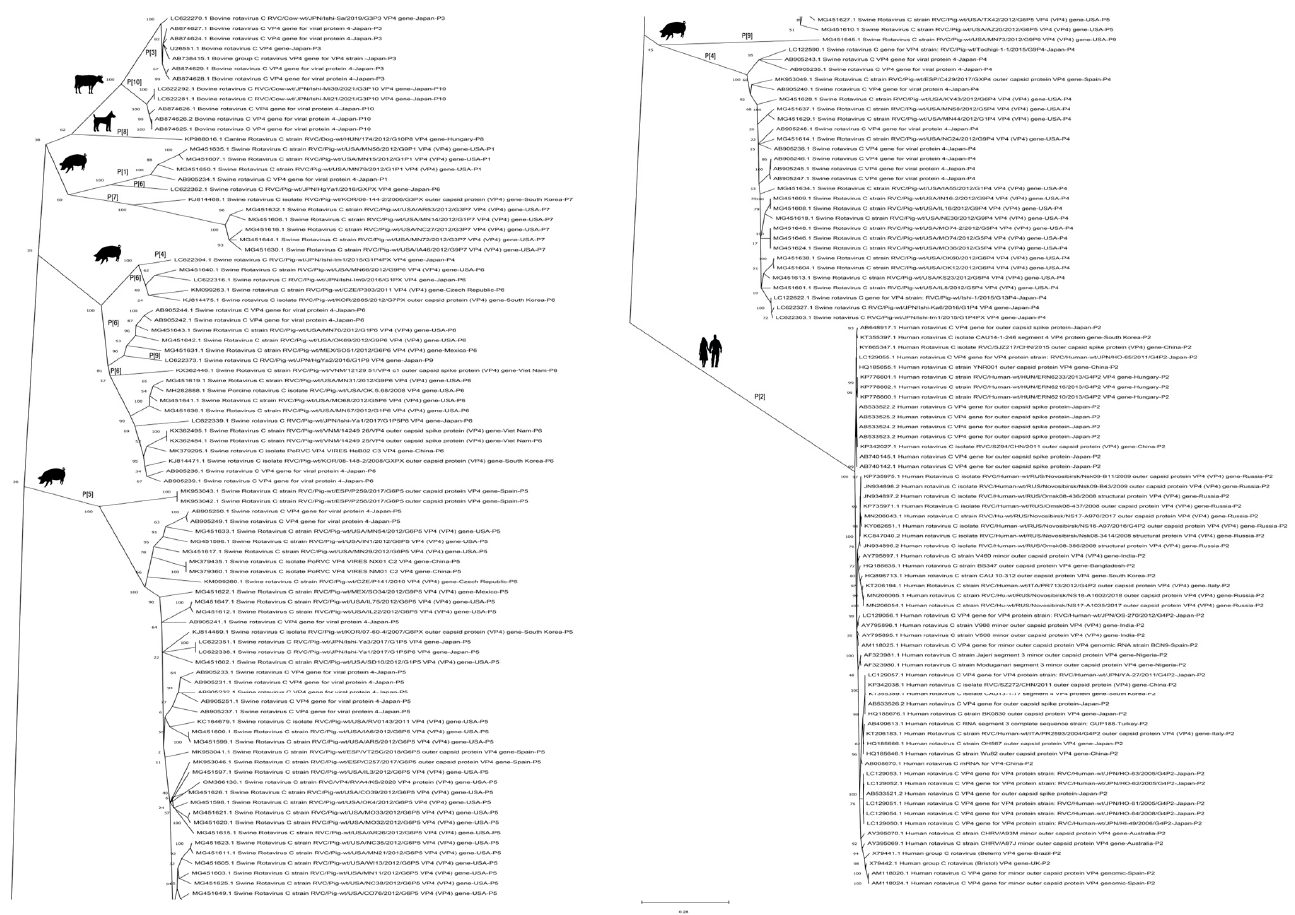
Figure 3. Phylogenetic tree of RVC VP4. The phylogenetic tree was constructed using the maximum- likelihood method based on the GTR+G+I model, and bootstrap values were calculated with 1000 replicates. The sequence information used in the phylogenetic analysis is shown in Table S2.